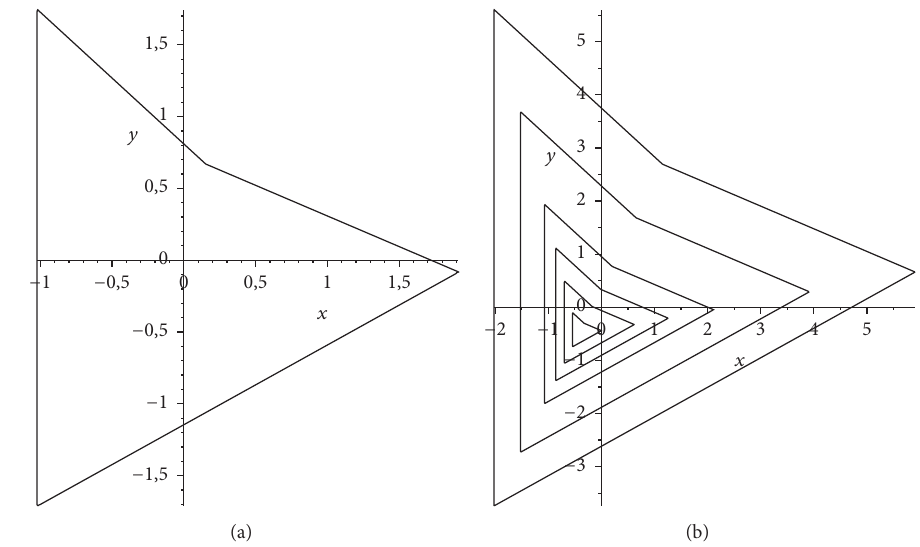
Figure 7: Tetragon P (a) and level sets of the density of 𝑋 (b) in Example A.3.